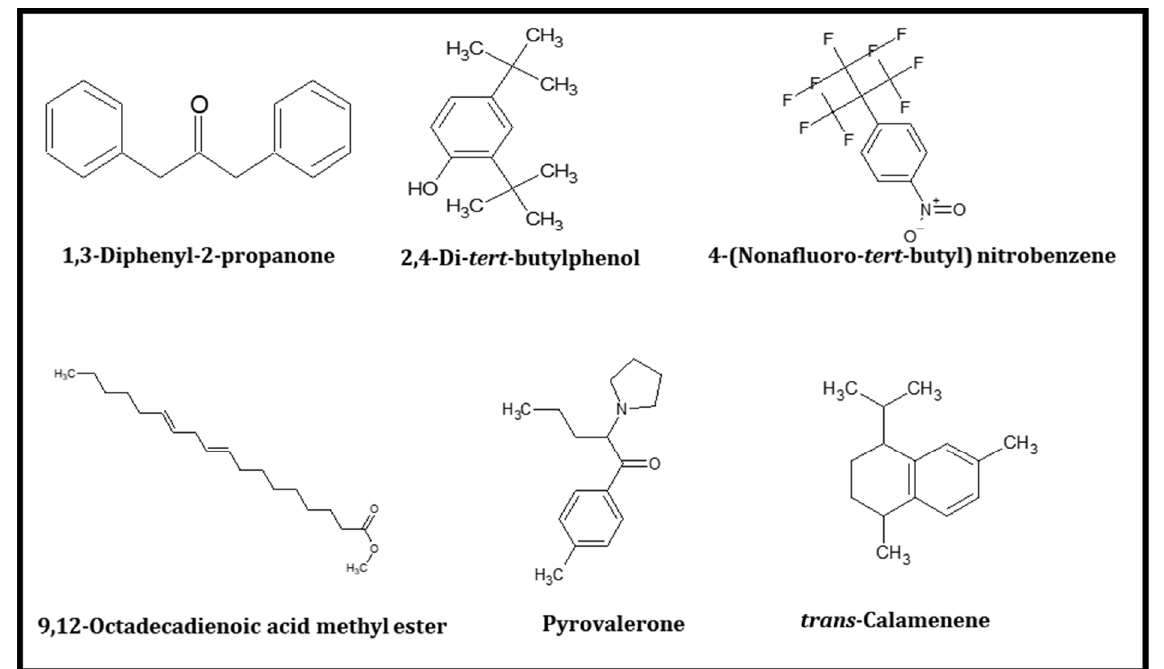
Figure 1. Structures of six best score volatile compounds from fermented soybean Cheonggukjang.